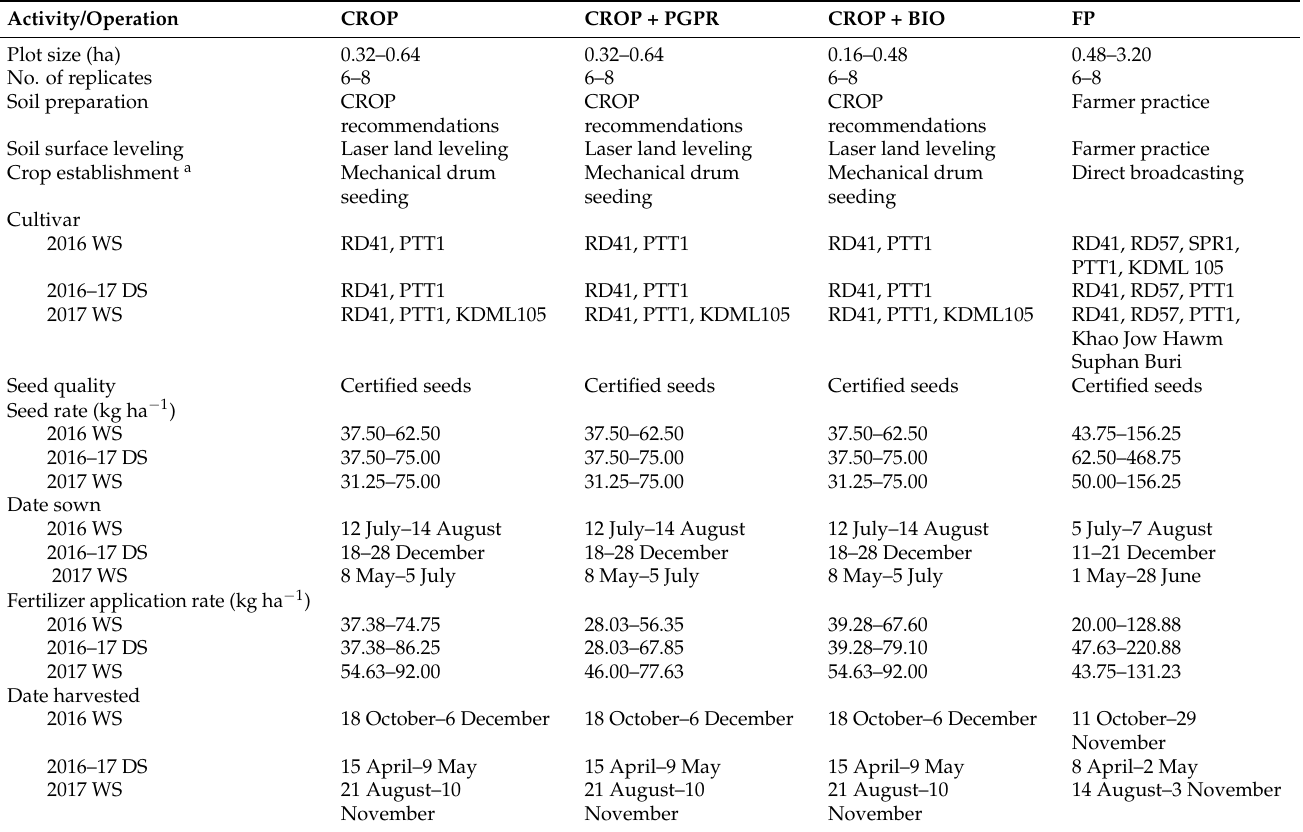
Table 1. Summary of field activities for the four field trial treatments in Nakhon Sawan and Chainat provinces during the 2016 WS, 2016–17 DS and 2017